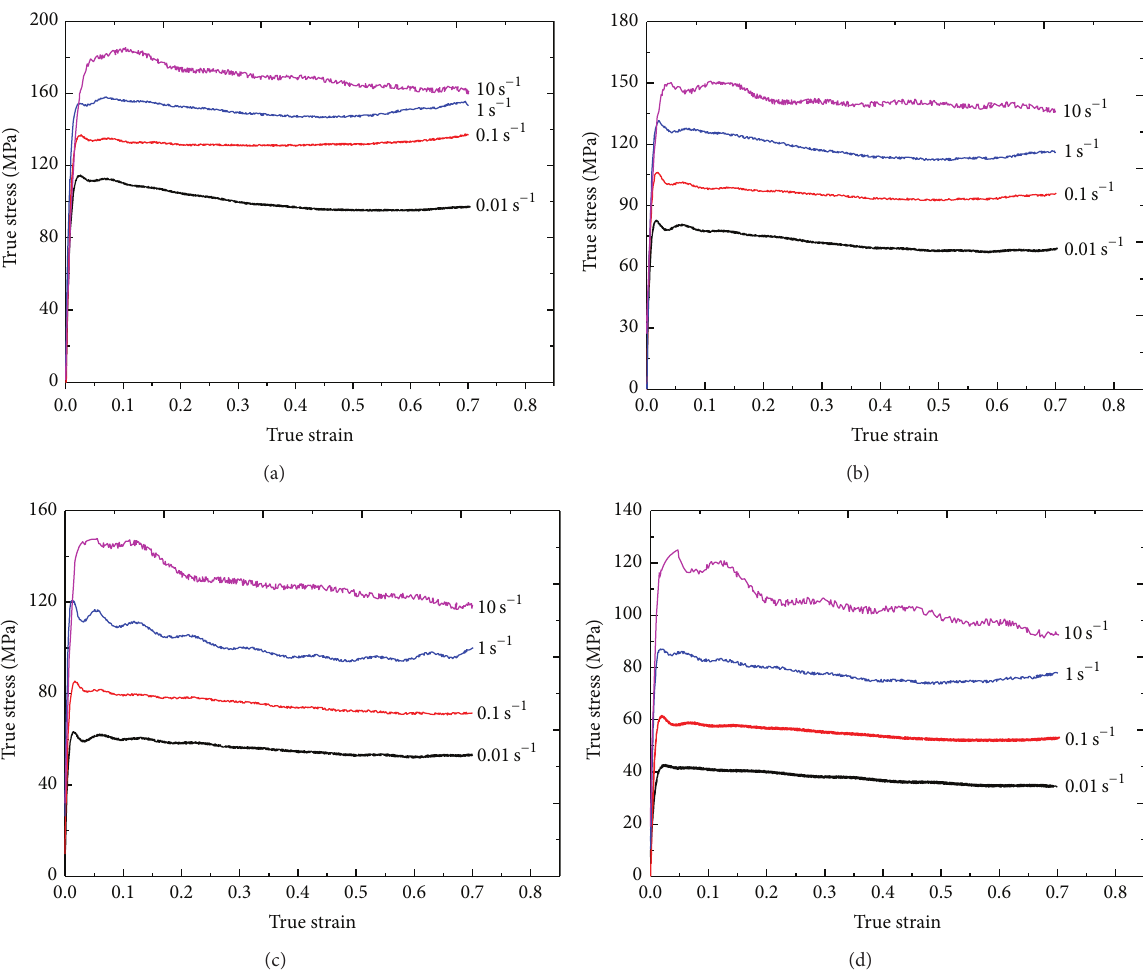
temperature were obtained through compress tests